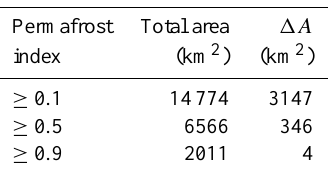
Table 6. Estimated permafrost index areas for the Alps calculated without the offset 1 Db = 2 ◦ C for vegetated areas. 1A refers to the difference in area between estimated permafrost distribution calcu- lated with (Table 5) and without offset 1 Db